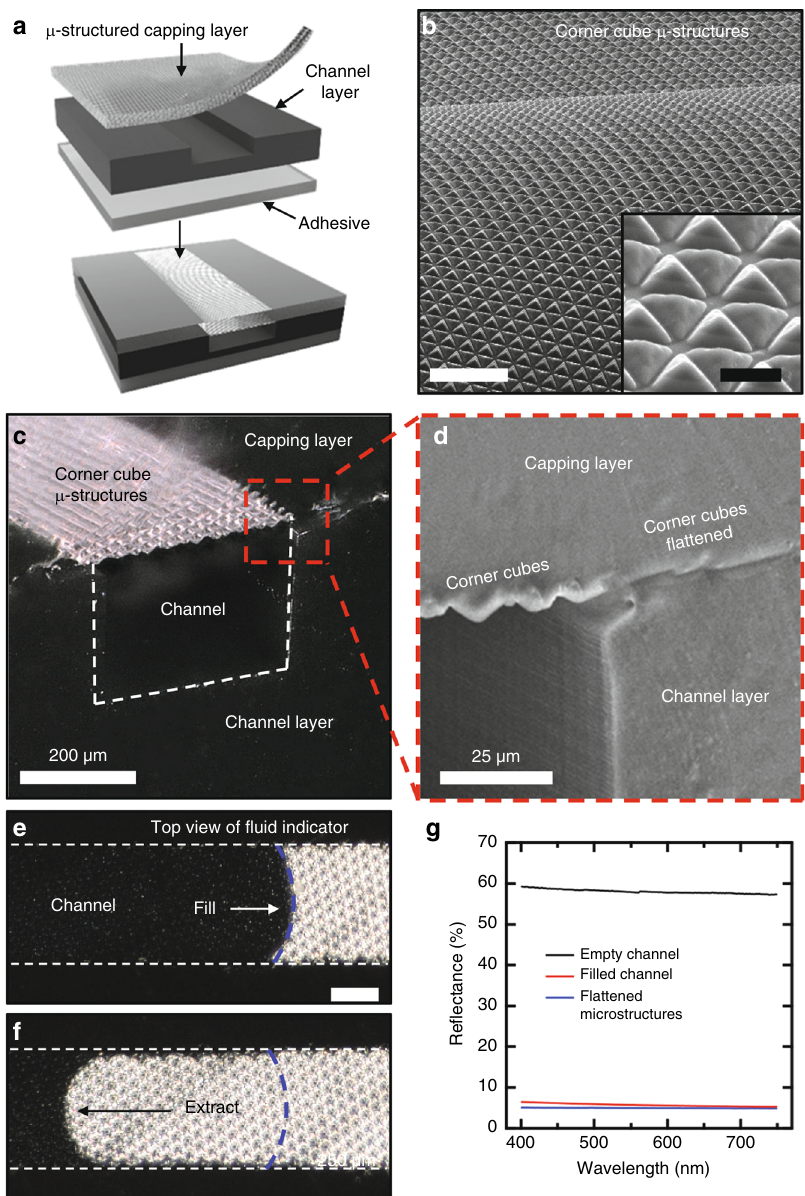
Fig. 2 Reversible visual indicator of fi lling of sweat into the device. a Lamination of a transparent microstructured capping layer against a black base layer with molded features of relief forms micro fl uidic channels with embedded fl uid indicators. b Scanning electron micrographs of microstructures formed in the geometry of re fl ective corner cubes on the surface of an elastomer by molding against a pattern of photoresist fabricated via grayscale lithography. Scale bar: 100 µ m. Inset scale bar: 20 µ m. c Optical micrograph of the cross section of a micro fl uidic channel. d Laminating these soft, self-adhesive, microstructures onto the channel layer fl attens the relief to eliminate the associated optical effects in areas outside the channel. e The approximate matching of the refractive index of the sweat with the elastomer eliminates re fl ections from the microstructures. Scale bar: 250 µ m. f Extraction of fl uid resets these optical effects. g Optical re fl ectance of empty channels, fi lled channels, and fl attened corner-cube microstructures. The resulting appearance changes from white, in the empty, re fl ective state, to black in the fi lled, transparent